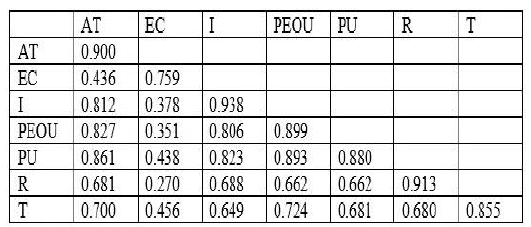
Table 2: Discriminant Validity Analysis based on Fornell-Larcker Criterion